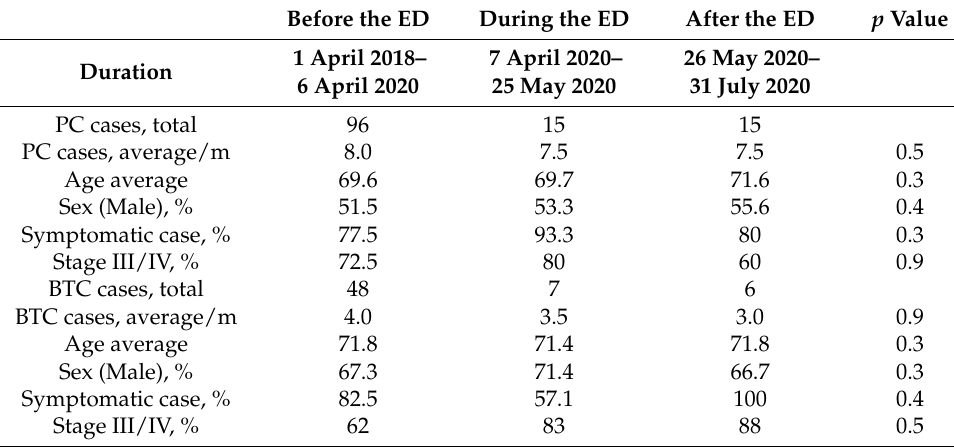
Table 1. Details of pancreaticobiliary Cancer at Each Period.